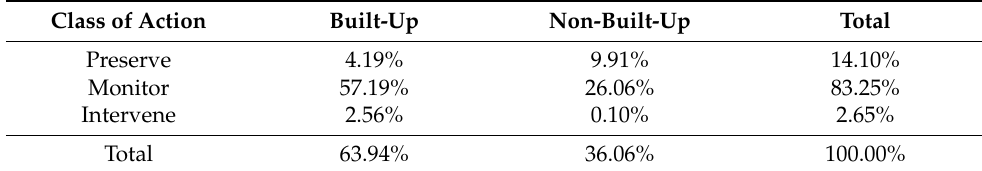
Table 16. Distribution of Built-up category per IUHI class of action based on NDBI.